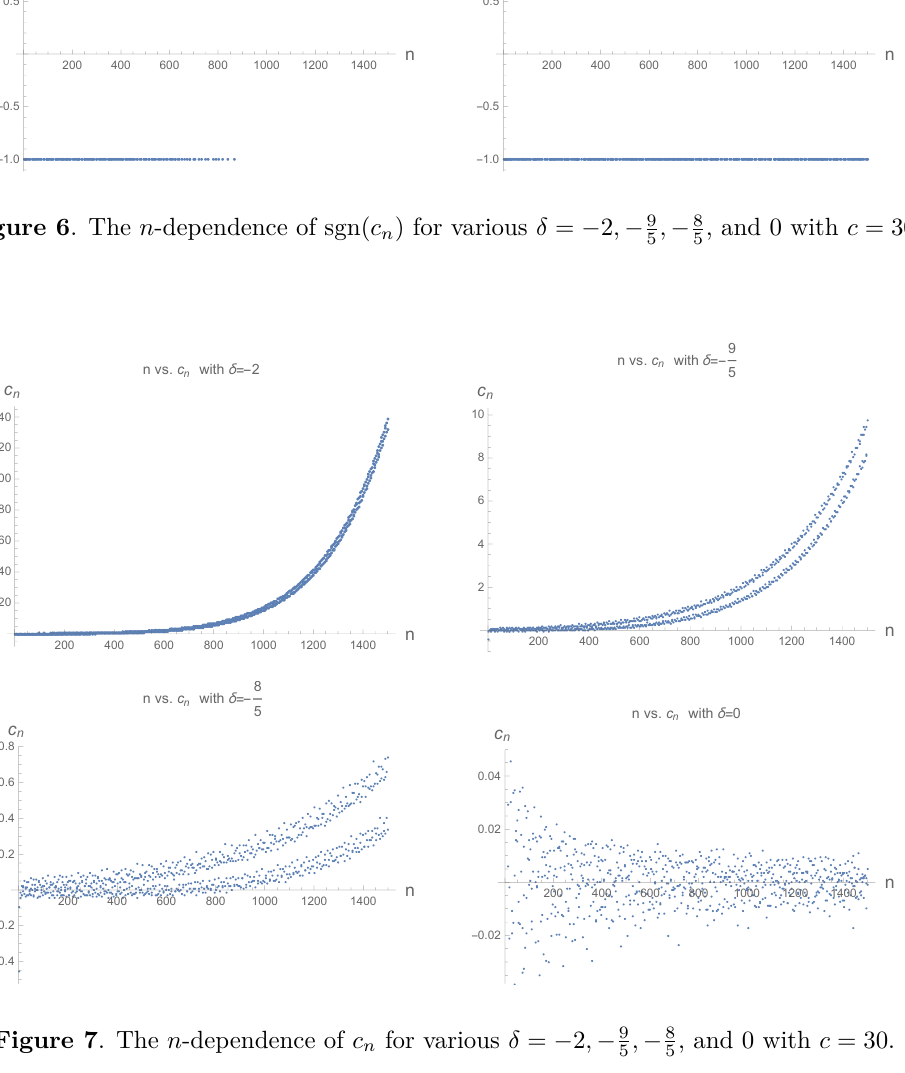
Figure 7 . The n -dependence of c n for various δ = − 2 , − 9